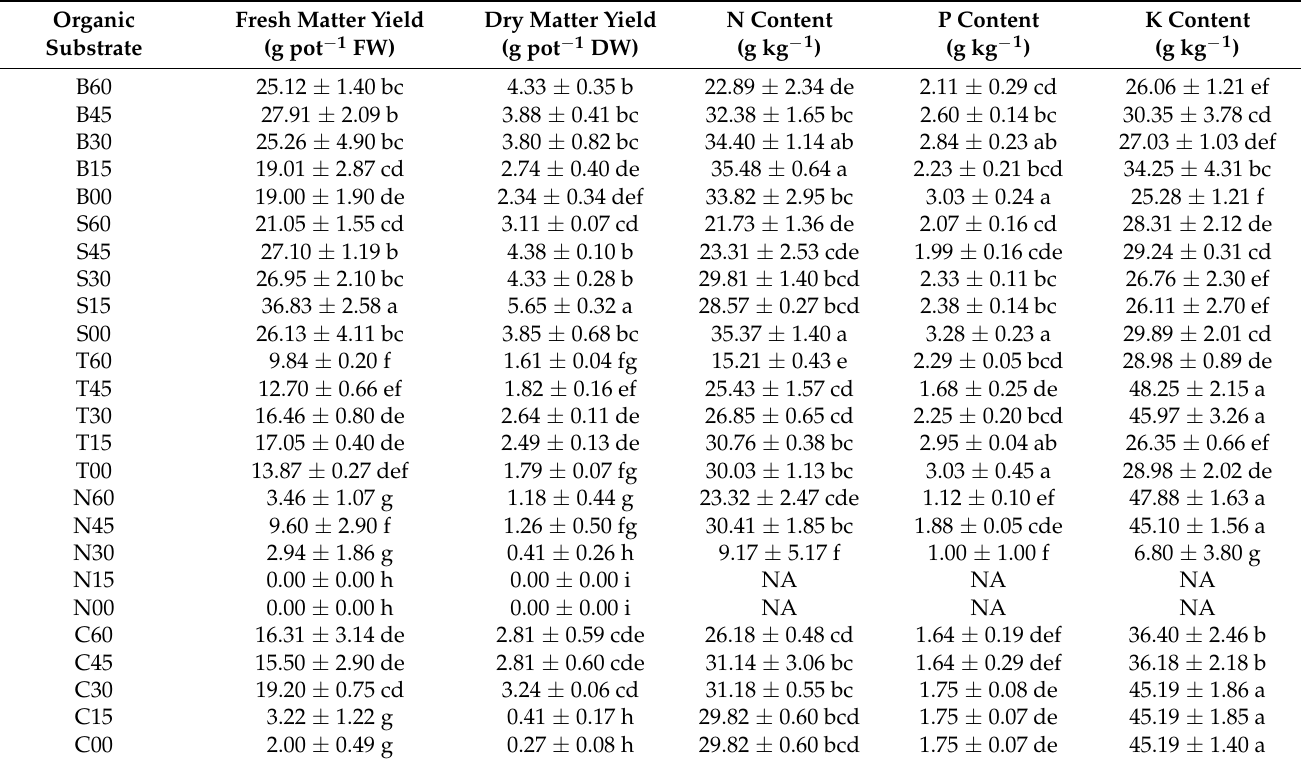
Table 2. Yield, moisture, and N, P, and K contents of parsley grown on different organic substrates 1 .